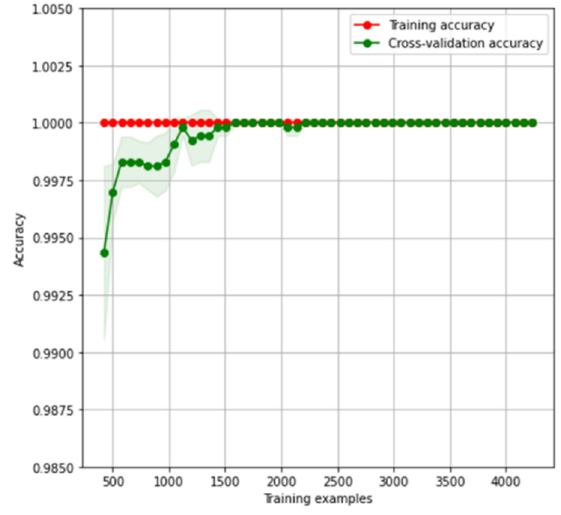
Figure 5. Learning curves for the histogram-based gradient boosting classifier model using 51 features from the SARS-CoV-2-RBV1 dataset.